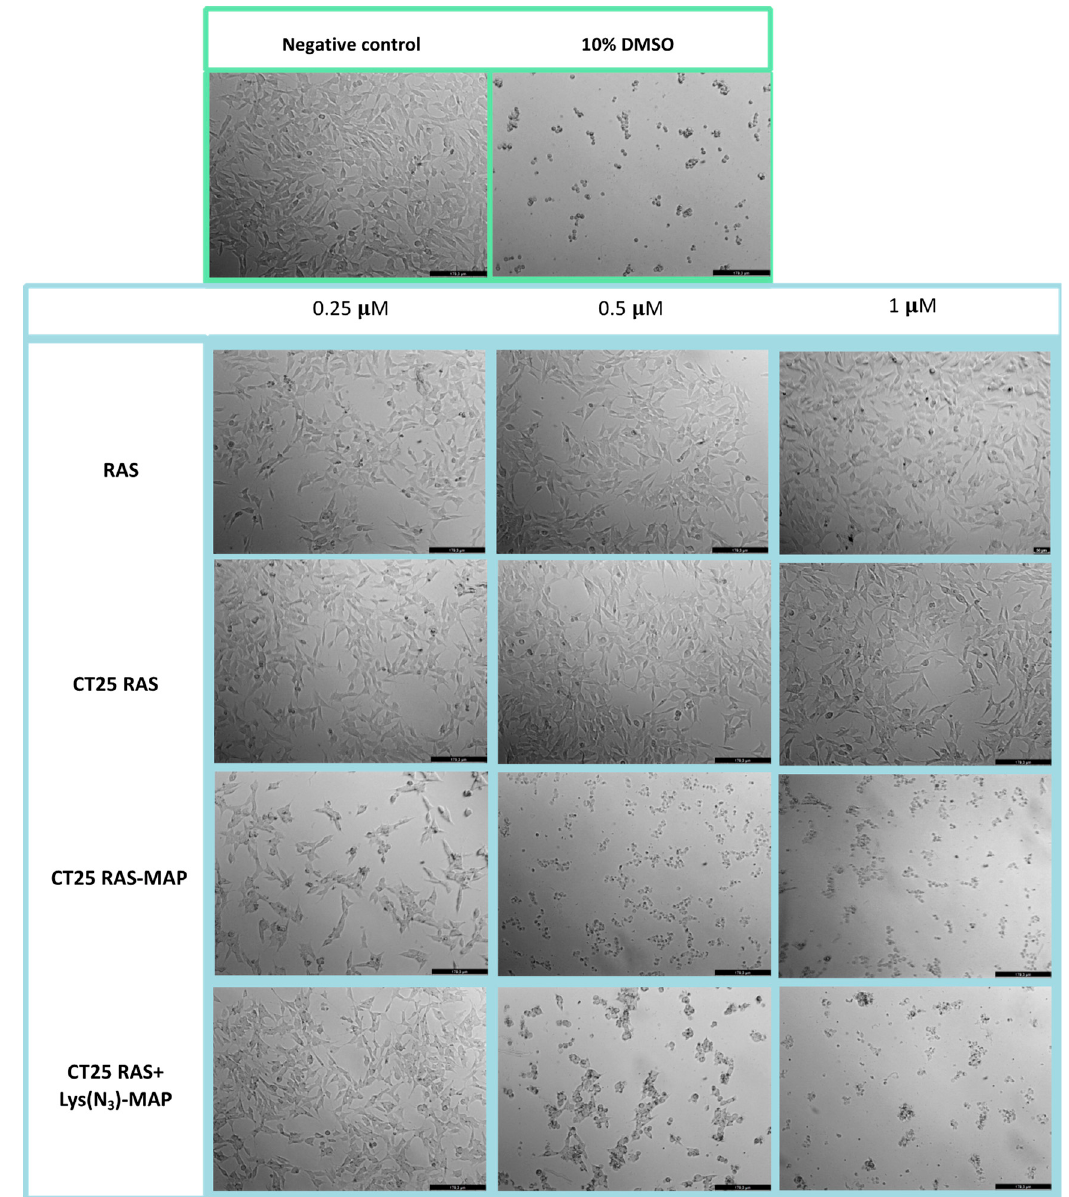
Figure 14. Microscope cellular visualization through Leica DFC350 FX of treatment with negative control (ultra-purified H 2 O), positive control (10% DMSO), free drug, and NLC-loaded formulations (CT25RAS, CT25RAS-MAP and CT25 RAS + Lys(N 3 )-MAP) on SH-SY5Y cell line at a concentration of 0.25, 0.5, and 1 μ M.